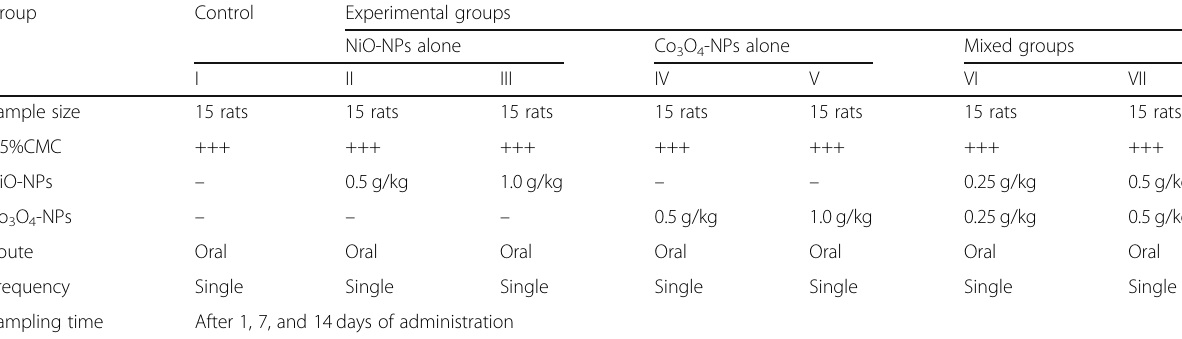
Table 1 The experimental design of the